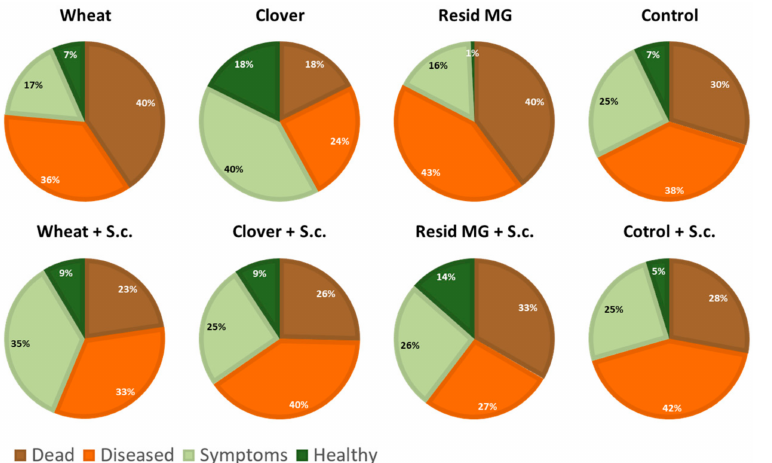
Figure 8. Field wilt assessment. Values were determined at 80 DAS (25 DAF). The experiment is described in Figure 2. Statistically significant differences (one-way ANOVA, p < 0.05) were found in the healthy plants between the clover and the Resid MG treatments, in the symptomatic plants between the clover and the wheat treatments and in the dead plants between the clover and the Resid MG treatments (all without tillage).